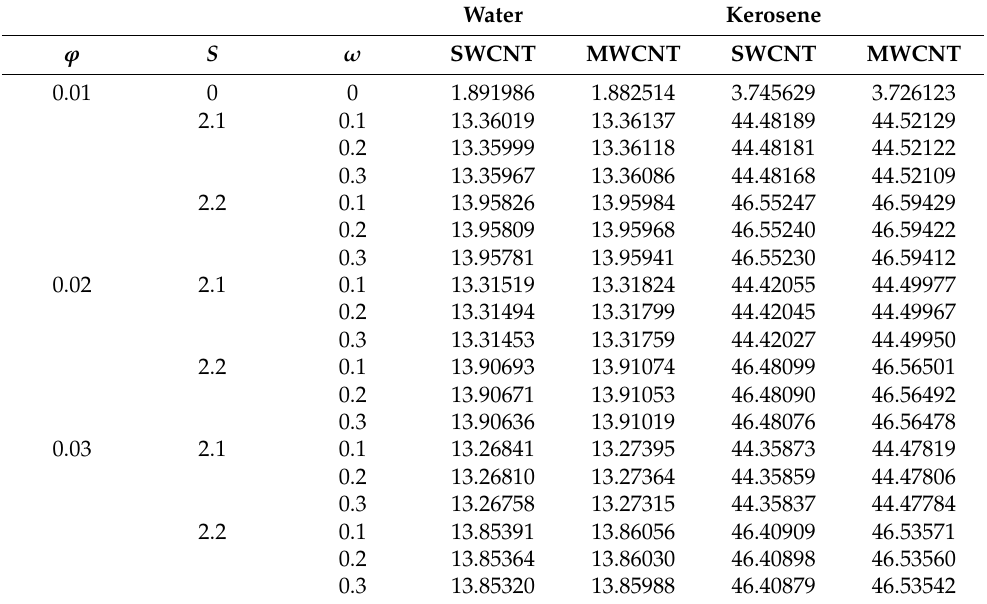
Table 5. Values of Re 1/2 x Nu x for different values of ϕ , S and ω when ε = 1.0 (stretching case) for both water and kerosene base